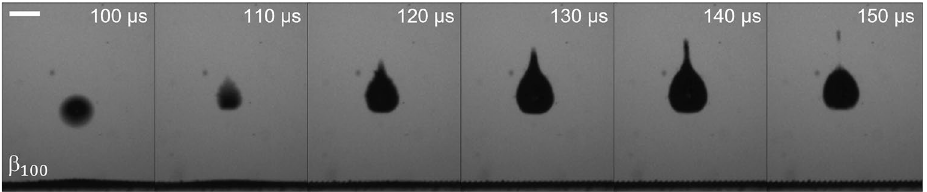
Figure 6. Sequence of images showing micro-jet evolution during cavitation bubble collapse (γ = 2, β 100 ). The scale bar is 500